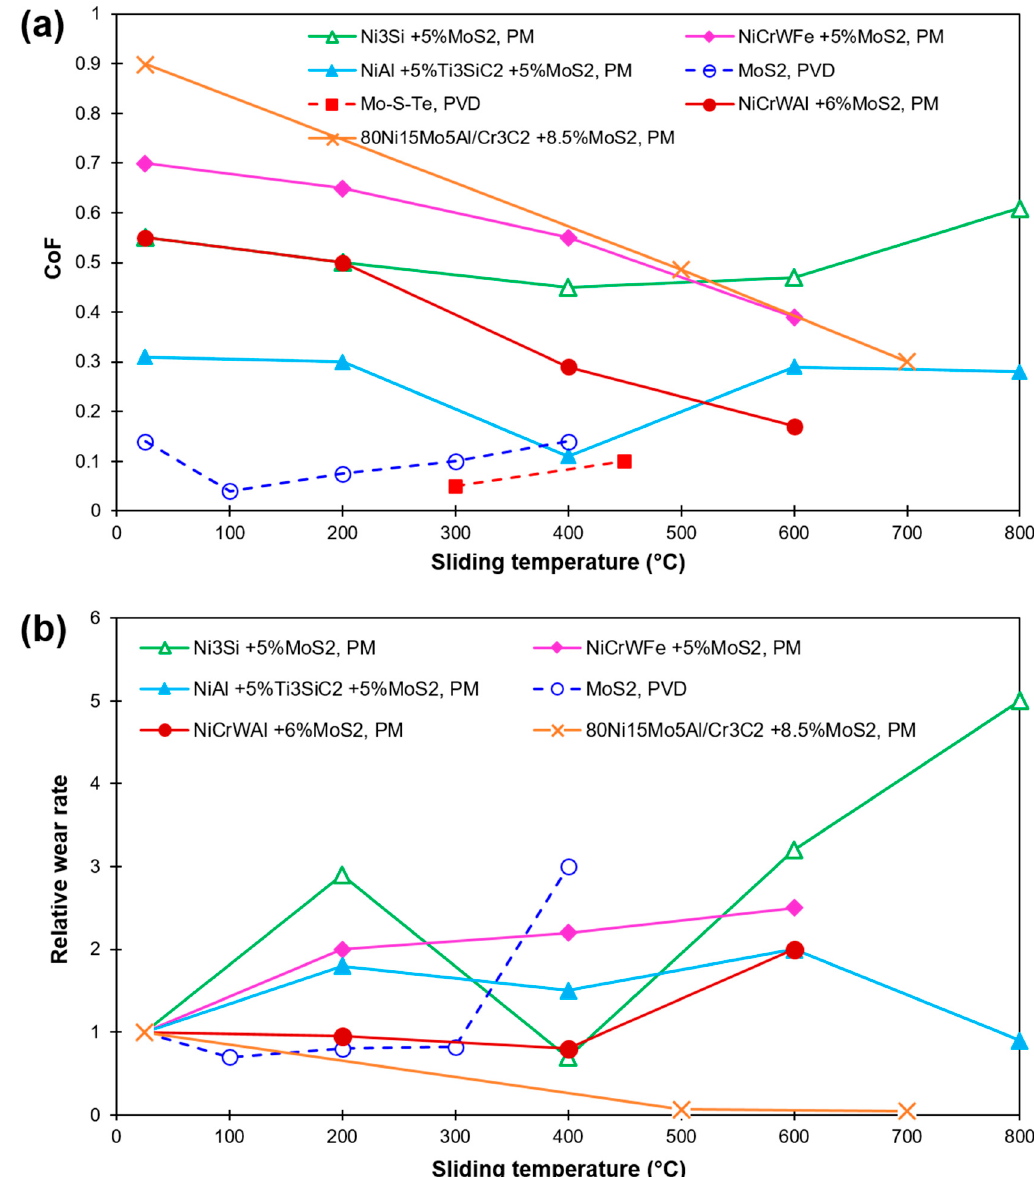
Figure 6. HT sliding results of MoS 2 -based composites and coatings as found in recent literature ( a ) CoF; ( b ) Relative wear rate (in relation to their corresponding RT wear). Values are labeled as per MoS 2 concentration, matrix material, and fabrication method [47–53].